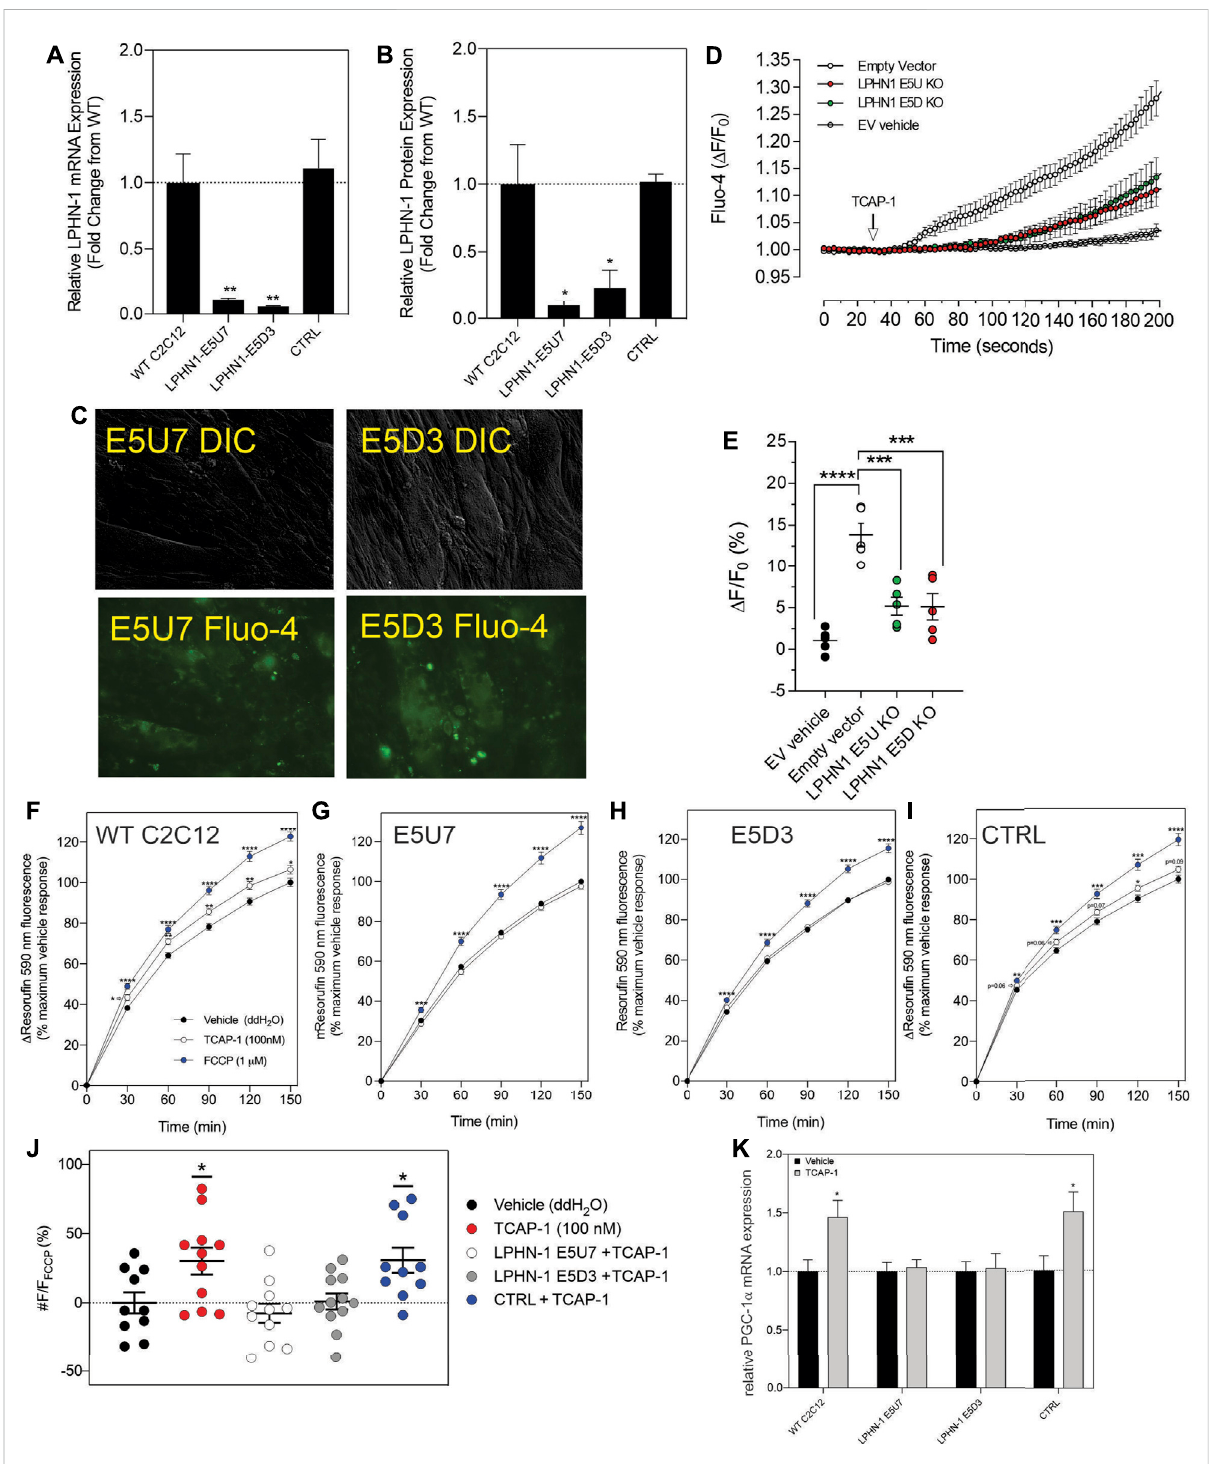
FIGURE 11 CRISPR-based knockouts of the LPHN-1 and -3 genes in C2C12 cells. The two clones (E5U7) (A) and (E5D3) (B) signi fi cantly reduced LPHN-1 expression relative to NT and WT cells. (C) . The morphology of the C2C12 cells were normal in both transfected cell lines. (D) . Changes in cytosolic Ca 2+ accumulationinthevariouscelltypes. (E) .Quanti fi cationofthedatashownin “ D ” after200 s. (F – I) .ChangesinNADHproductionasdetermined by the resasurin assay where the WT cells show a signi fi cant increase in the NADH-mediated resoru fi n fl uorescence but is ablated in the E5U7 (G) andE5D3 (H) KOclones, butisretainedinthenullvector (NT)clone (I) . (J) .Quanti fi cationofthedatashown in (F – I) , (K) .Reduction inPGA- 1 α mRNA expression by PCR inE5U7 and E5D3clones. * p < 0.05; ** p < 0.01; *** p < 0.001; **** p < 0.0001. Mean ±SEM indicated n =7 – 8. Notethat CTRL refers to the null-vector control and that F/F0 has been set to “ 1 ” for